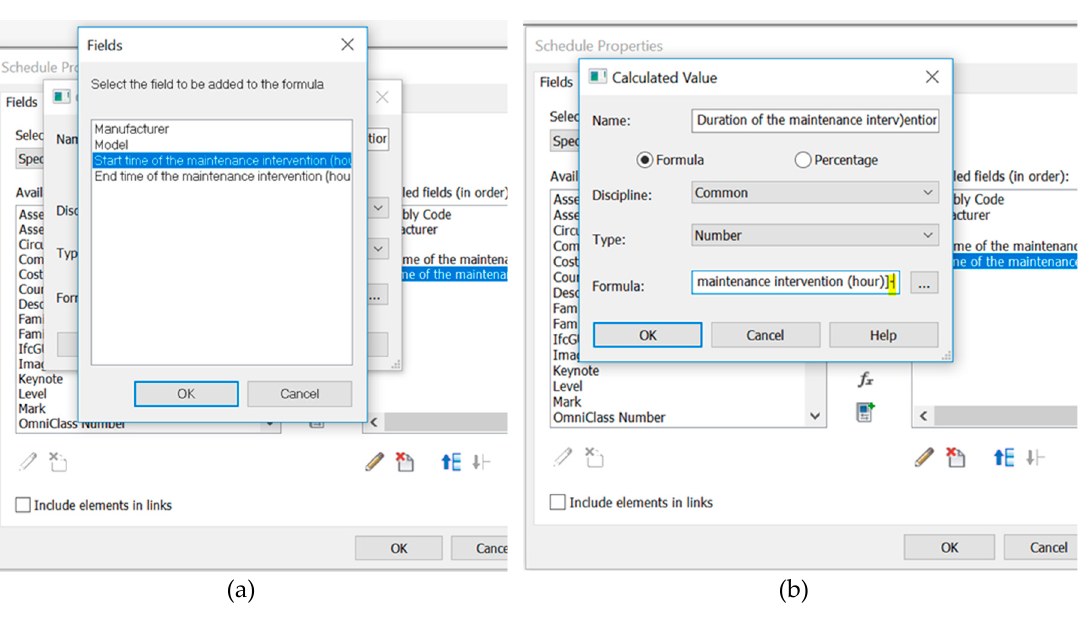
Figure 7. Maintenance schedules implementation: ( a ) definition of the sub-parameters; and ( b ) parameter “duration of maintenance intervention”. Buildings 2019 , 9 , x FOR PEER REVIEW